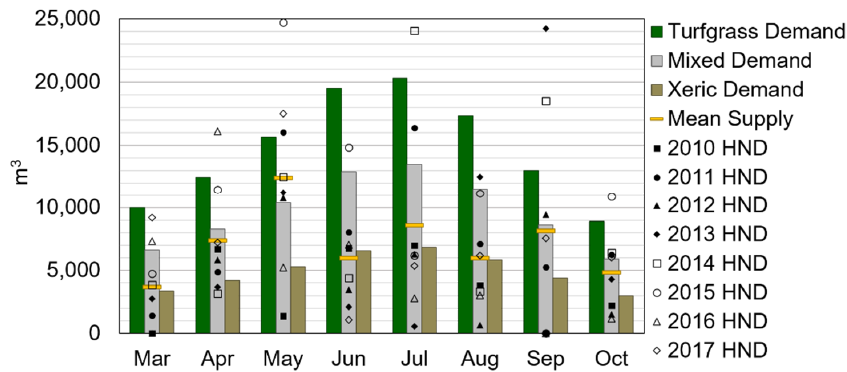
Figure 6. Monthly irrigation demand in example development compared with allowable harvest using HND factors at Sterling Ranch, 2010‒2017 precipitation.